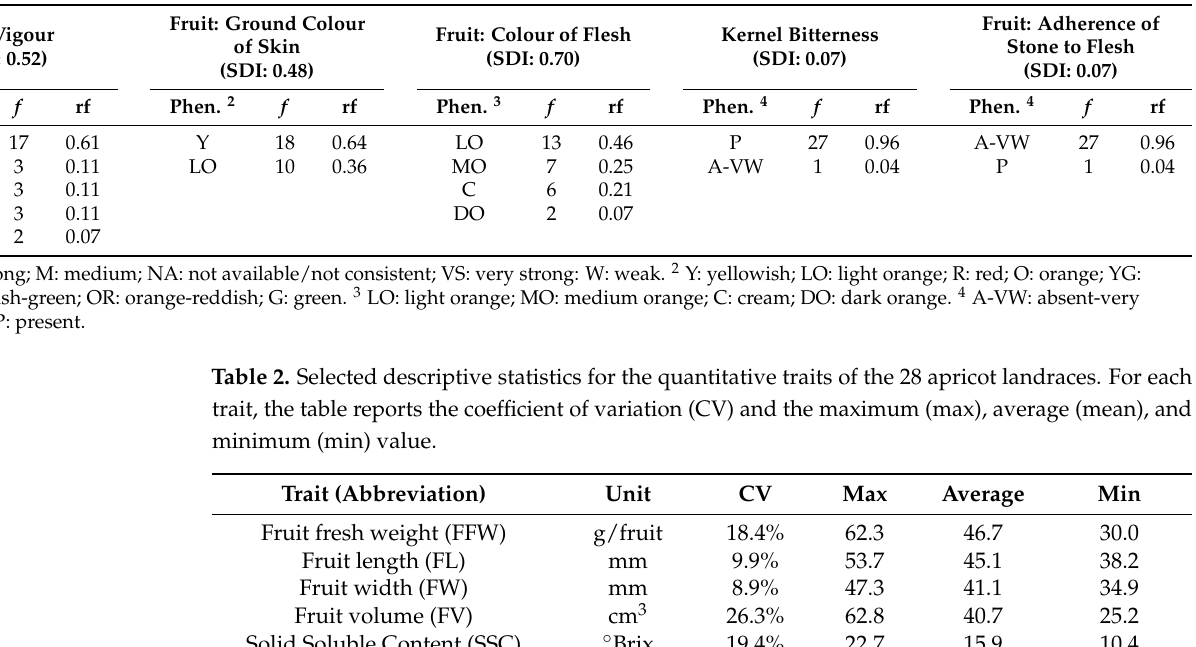
Table 1. Frequency ( f ) and relative frequency (rf) of the categorically scored traits in the germplasm collection. For each trait, phenotypes (Phen.) are ranked in decreasing order. For each qualitatively scored trait, the Simpson Index of Diversity (SDI) is also reported.